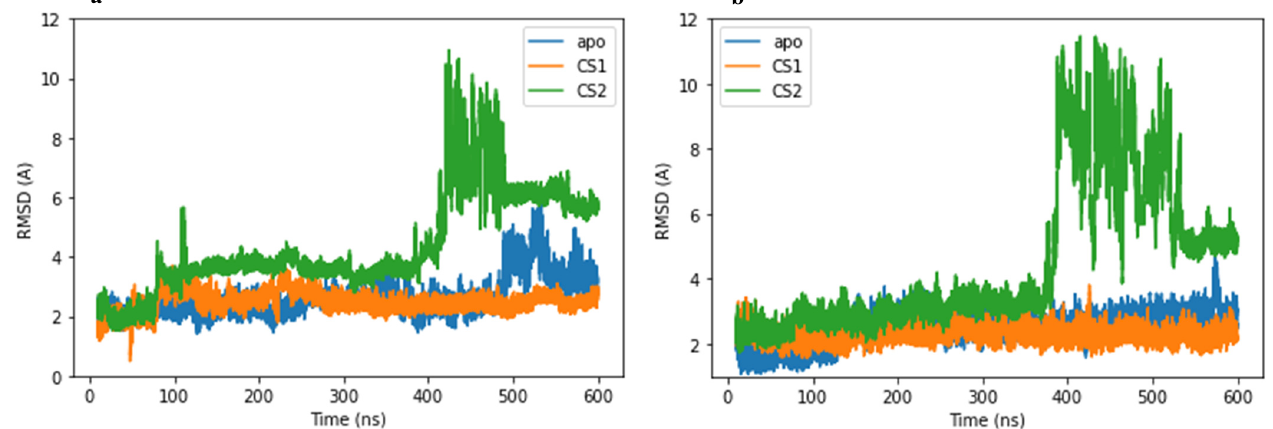
Figure 3. Root-mean-square deviation plot for ( a ) apo-3CLpro protease (blue) and complexes of 3CLpro with CS1 (orange) and CS2 (green) during the 600 ns MD simulation time. ( b ) apo-PLpro protease (blue) and complexes of PLpro with CS1 (orange) and CS2 (green) during the 600 ns MD simulation time.